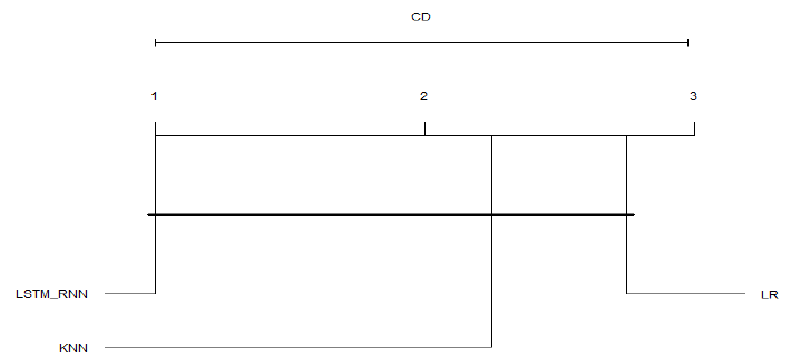
Figure 29. CDD graph for average binary classification.